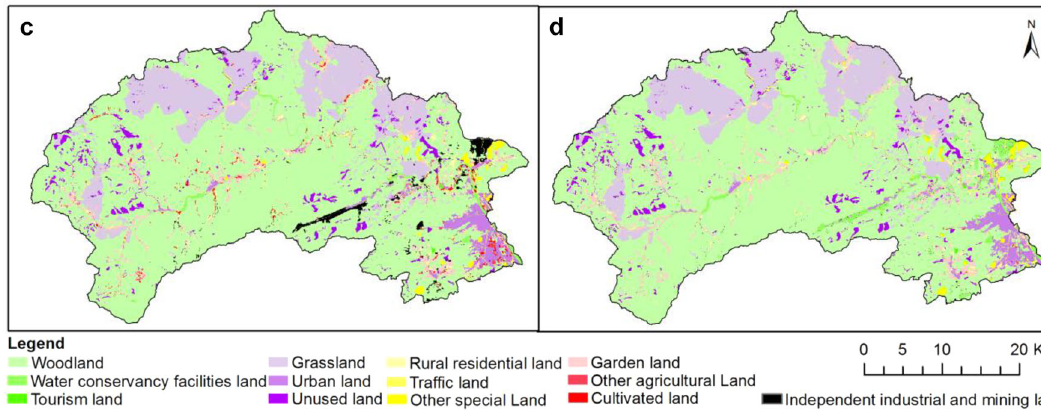
Fig. 6 Land use status of Mentougou District in 2010 ( c ) and simulated optimization results in 2025 ( d